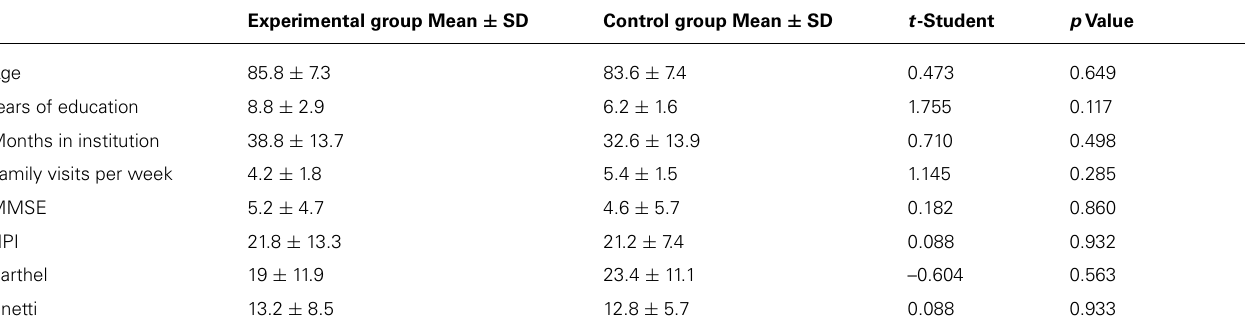
Table 2 | Demographic and clinical